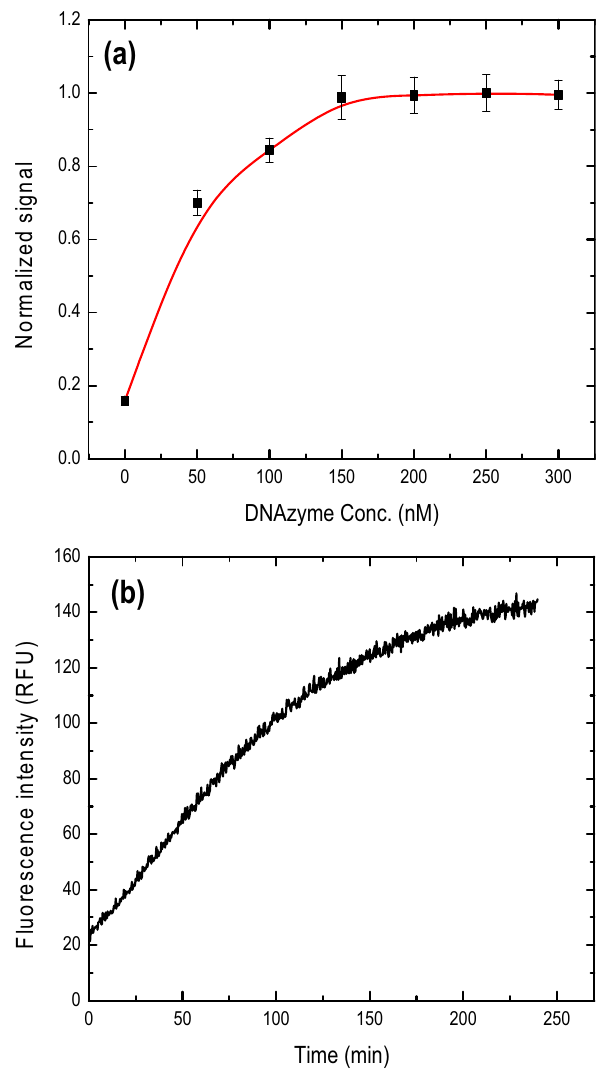
Figure 3: Condition optimization. ( a ) Normalized signal at various DNAzyme concentrations. The error bars represent the standard error of three independent measurements. ( b ) Time variation of fl uorescence